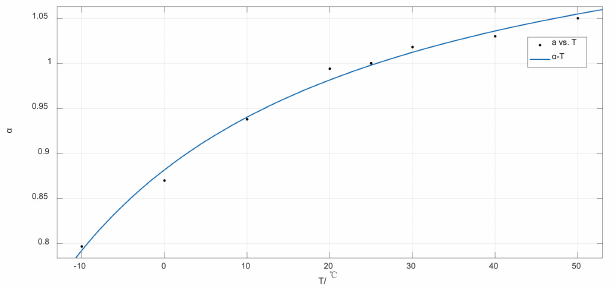
Figure 12. Variation of battery capacity compensation factor with